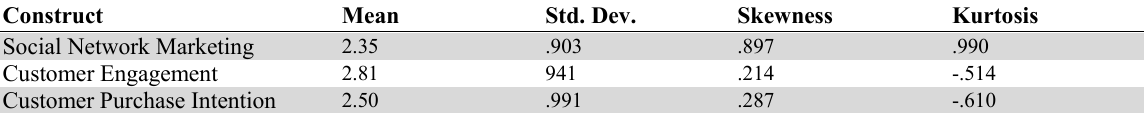
Descriptive Statistics